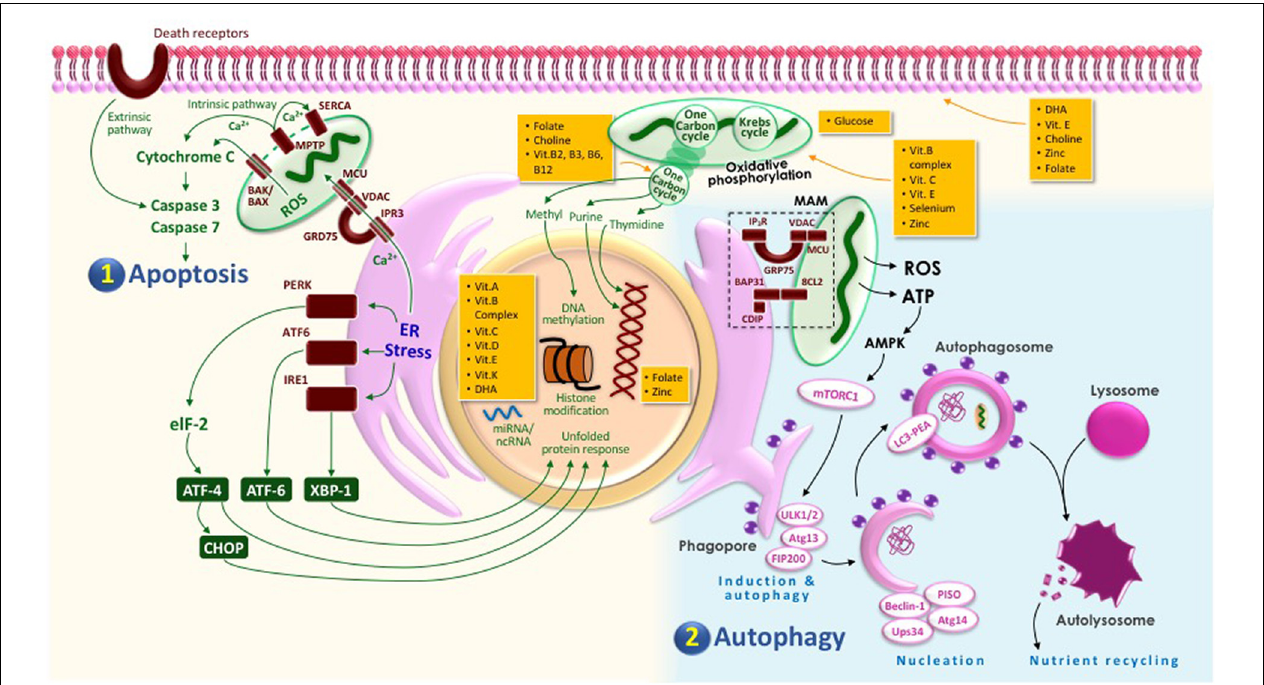
FIGURE 1 | Physiological cell death pathways in a trophoblast cell and the associated nutrition required in maintaining cellular wellness. In a physiological state, the following cell death mechanisms occur in a trophoblast in order to ensure appropriate invasion: (1) apoptosis and (2) autophagy.